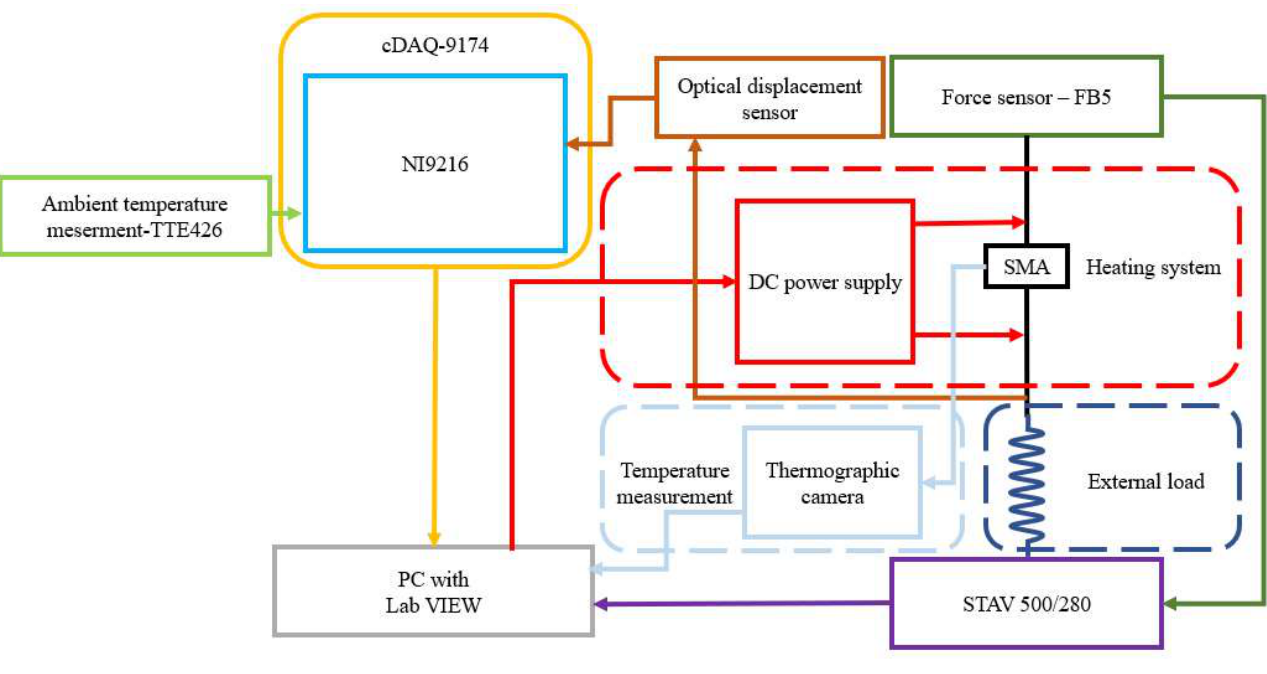
Figure 2. Scheme of the measurement system.